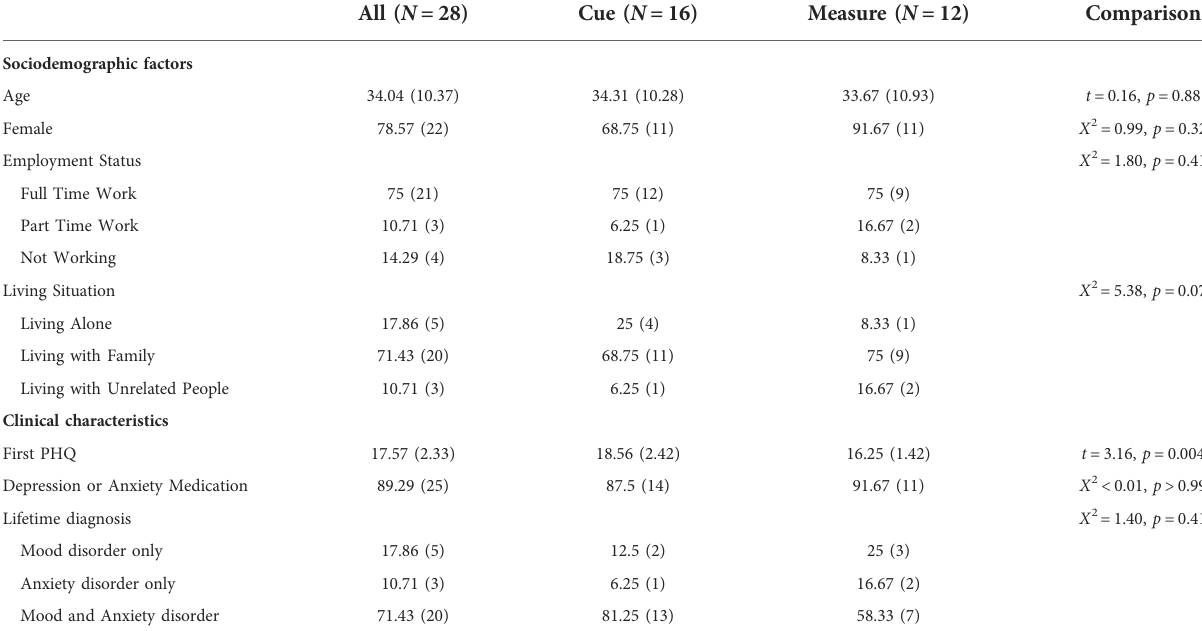
TABLE 2 Demographic and clinical characteristics for the depressed-at-entry exploratory subsample (baseline PHQ ≥ 15) – Cells show mean (SD) for continuous and % ( N ) for categorical